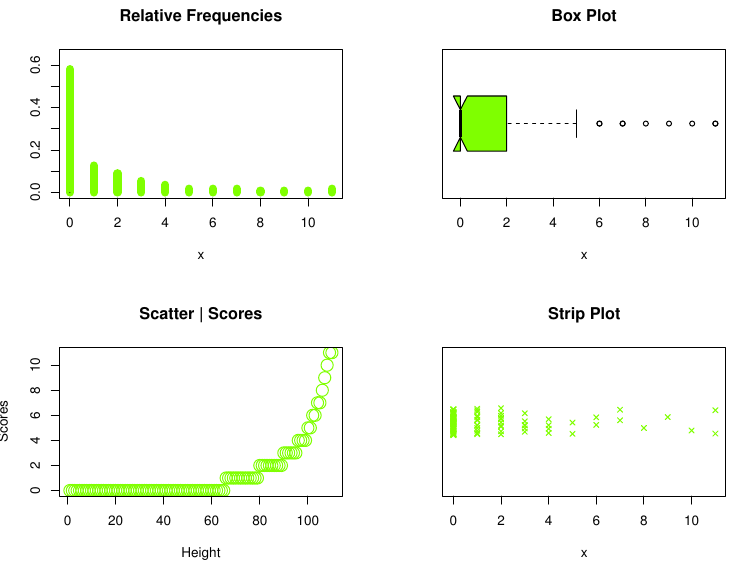
Figure 5. Nonparametric data plots. MLEs, standard errors (SEs), upper (U) and lower (L) confidence intervals (CIs) for the parameters, and goodness-of-fit measures (GOFMs) for kidney dysmorphogenetic data are reported in Tables